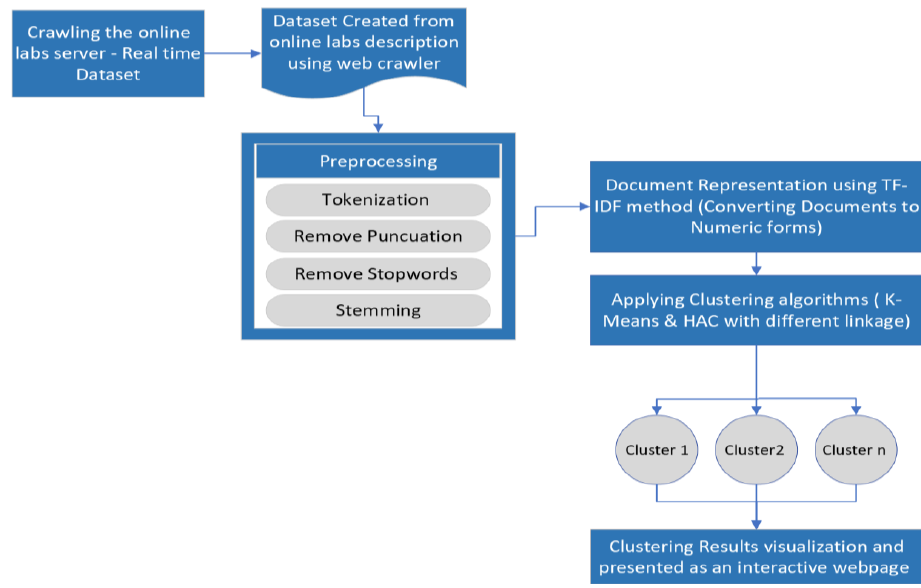
Figure 2. Methodological steps of the proposed